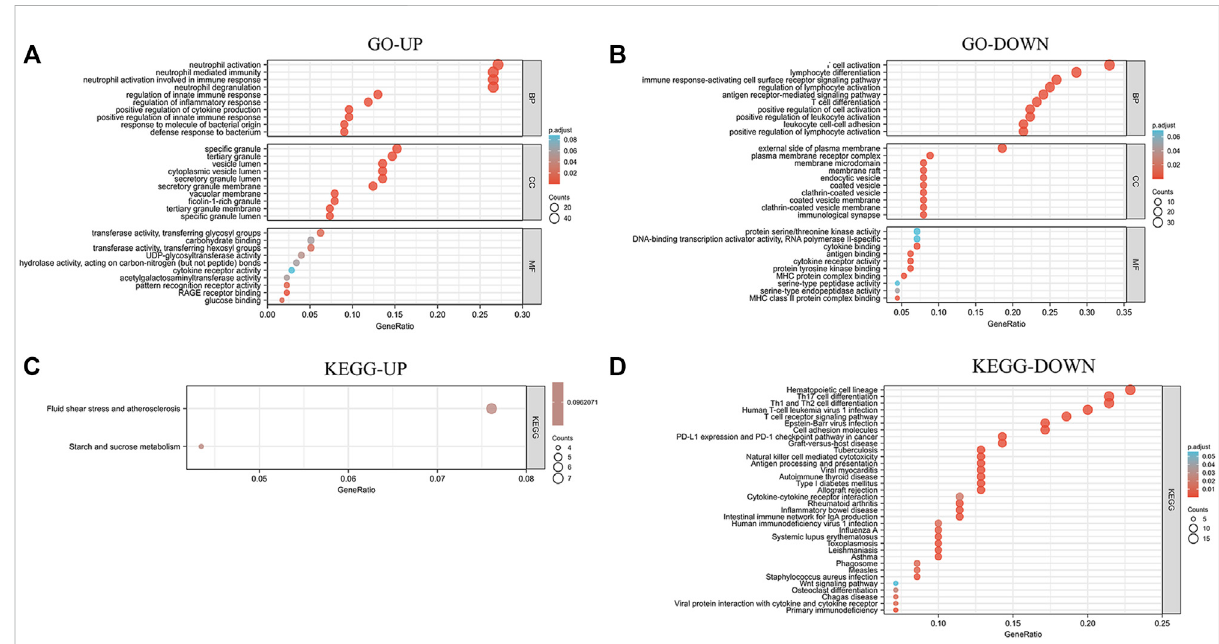
FIGURE 5 Analysis results of co-expressed genes in the GO and KEGG pathways. (A,B) Results of GO enrichment analysis of UP and DOWN DEmRNAs. (C,D) Results of KEGG pathway analysis of UP and DOWN DEmRNAs. DEmRNAs, differentially expressed mRNAs; GO, Gene Ontology; KEGG, Kyoto Encyclopedia of Genes and Genomes; UP, upregulated; DOWN,